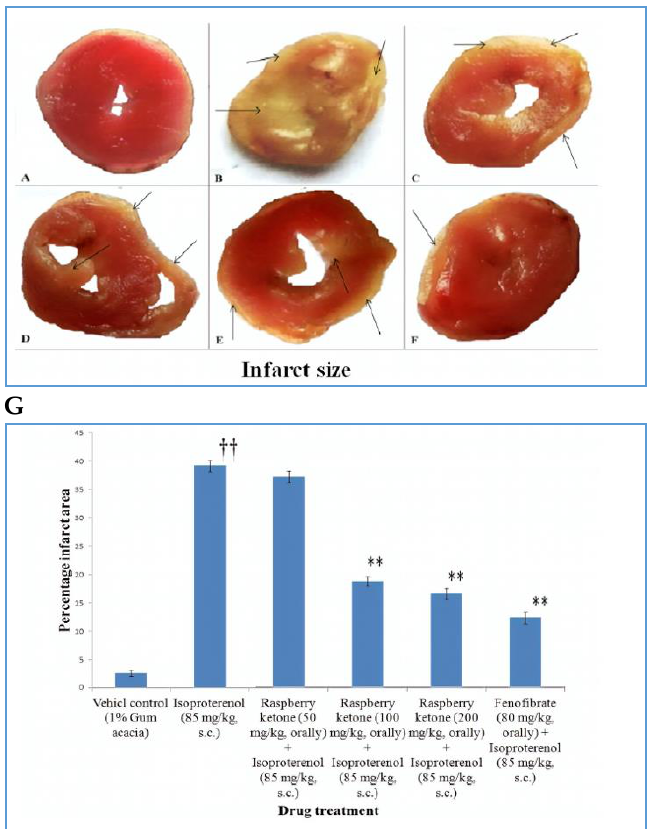
Figure 3. Representative figures showing the effect of RK and different drugs on the myocardial infarct size of various groups (shown with arrows). ( A ) Vehicle control (1% gum acacia), ( B ) iso- proterenol (85 mg/kg, s.c.), ( C ) RK (50 mg/kg, orally) +isoproterenol (85 mg/kg, s.c.), ( D ) RK (100 mg/kg, orally) +isoproterenol (85 mg/kg, s.c.), ( E ) RK (200 mg/kg, orally) + isoproterenol (85 mg/kg, s.c.), and ( F ) fenofibrate (80 mg/kg, orally) +isoproterenol (85 mg/kg, s.c.). The graph shows the percentage infarct area of different treatment groups ( G ). Each column represents the mean SEM. Significance was determined by one-way ANOVA followed by Dunnett’s t-test: ** p < 0.01 versus toxic control; †† p < 0.01 versus vehicle control. Adapted from